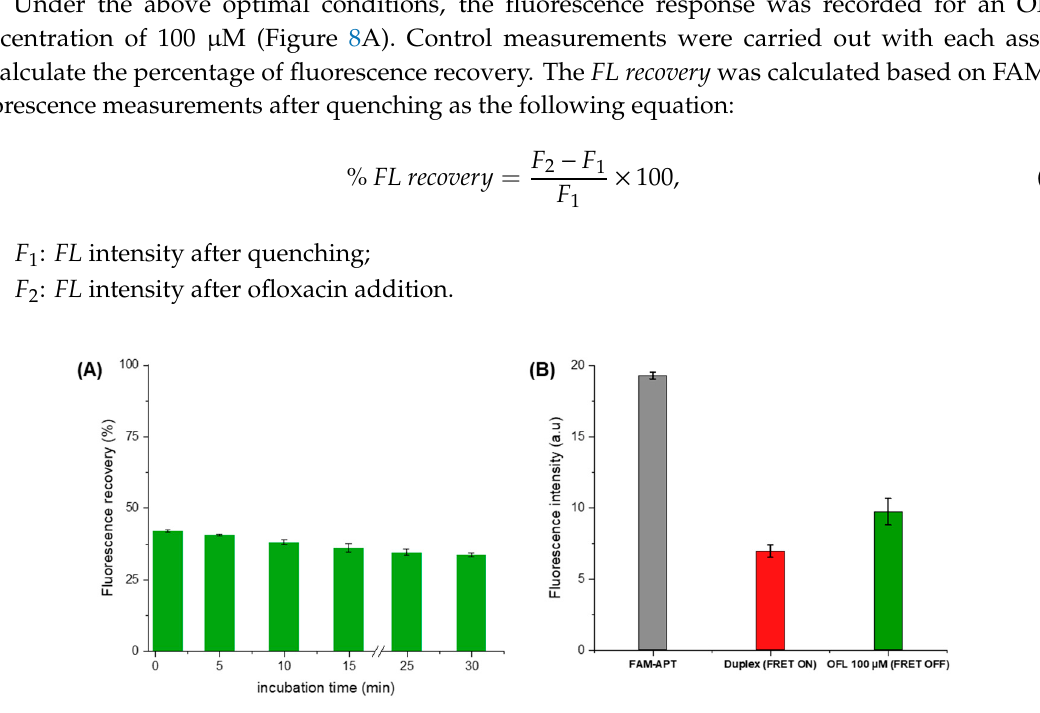
Figure 8. ( A ) Optimization of the ofloxacin incubation time as a function of fluorescence recovery ( B ) Fluorescence intensity at each aptasensing step in optimized conditions (5 min of OFL incubation).